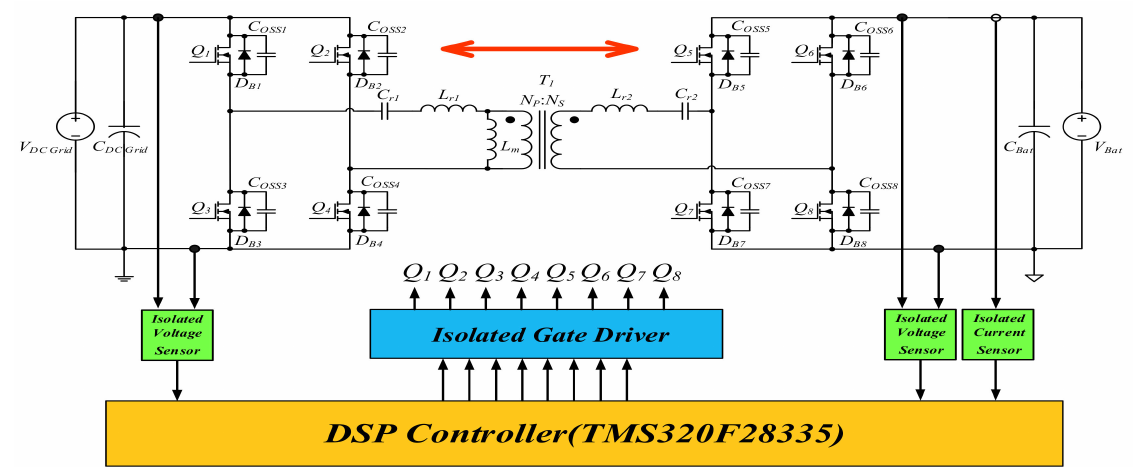
Figure 13. The overall system structure of the isolated bidirectional symmetric resonant converter.